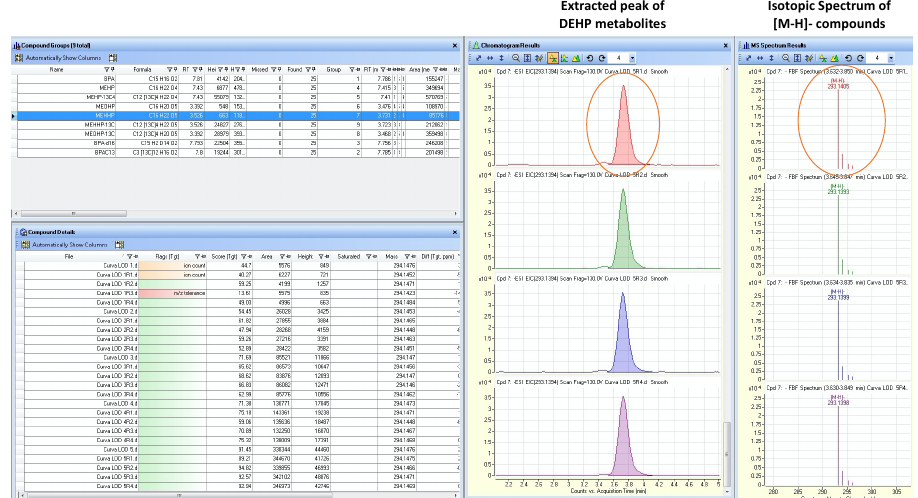
Figure A3. Chromatograms were analyzed with instrumental software Mass Hunter Profinder B.06.00 Profinder (Agilent, Santa Clara, CA, USA) with targeted feature extraction. Mass Profinder algorithm was used to identify and extract compounds by known chemical formulas ([M-H] − ±0.001 m/z tolerance. Table A1. Chemical features (molecular formulas, molecular weight (MW) and mass to charge ratio (m/z)) of MEHP, MEHOP, MEHHP and of their labelled standard compounds. Compound